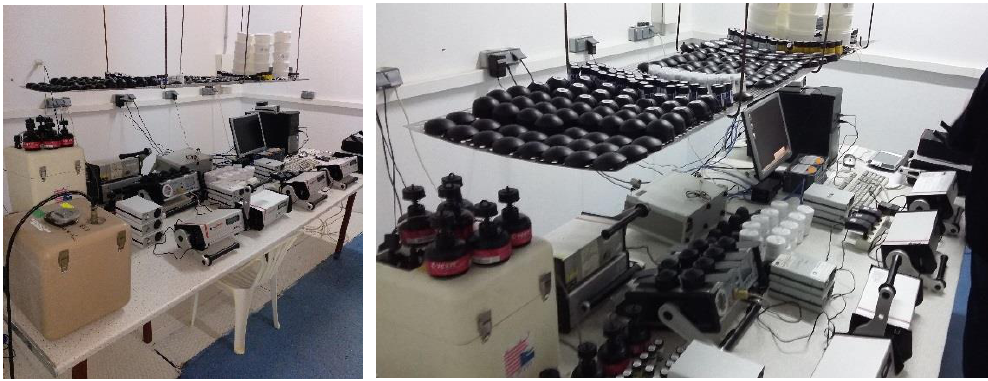
Figure 2. Radon devices inside Room1 (LNR: Laboratory of Natural Radiation).